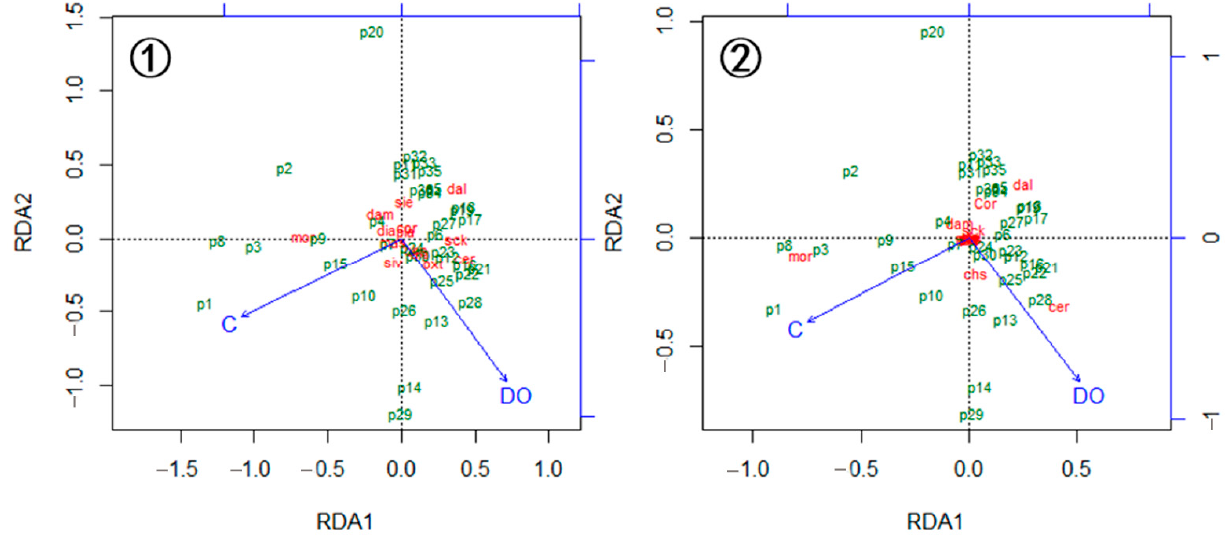
Figure 4. Redundancy analysis of cladoceran communities with presence/absence data (1) and relative abundance (2) Ab- breviation of species see Appendix A. Sampling sites in green font: p1–p37; species in red font, abbreviations codes, see Appendix A; blue arrows: significantly explaining environmental variables.